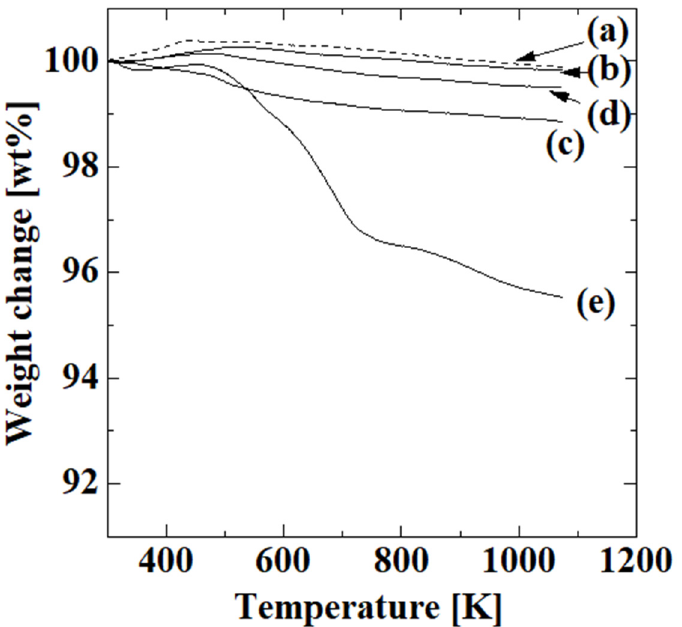
Figure 3. TGA results for the uncoated alumina support ( a ) and membranes obtained after first ( b ), second ( c ), third ( d ), and fourth steps with four polymerizations ( e ).